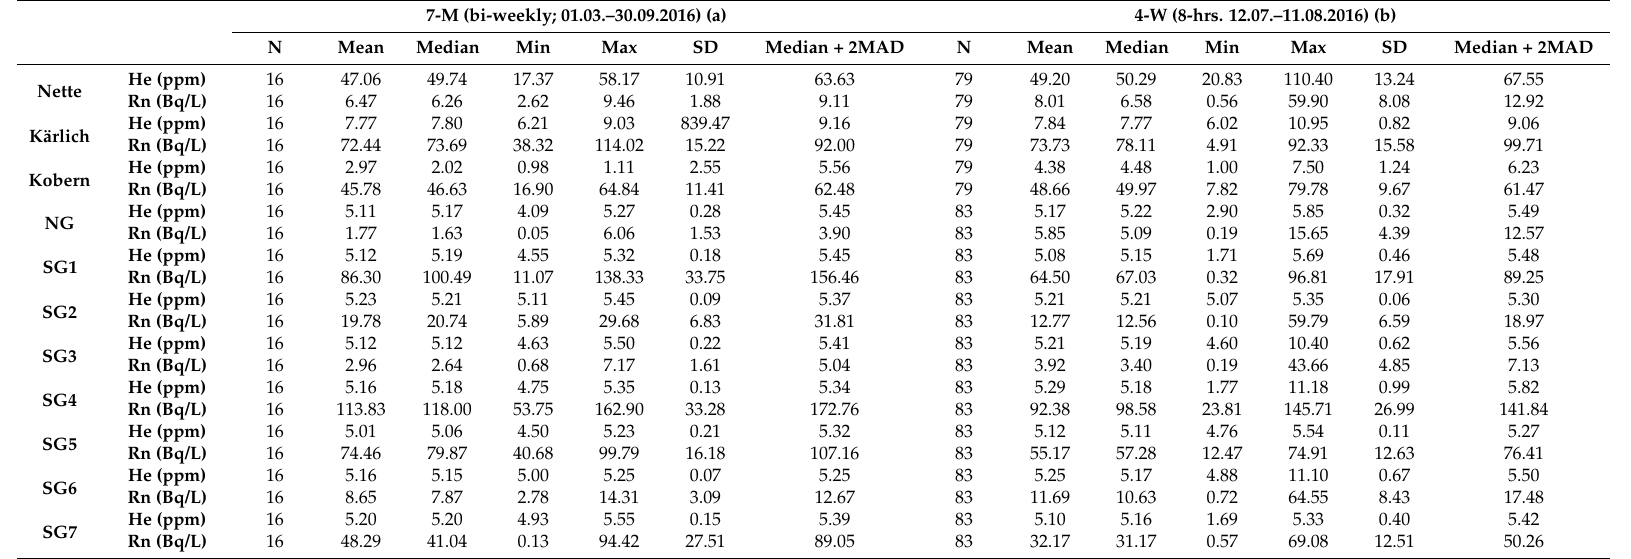
Table A4. Comparison of median He and Rn concentrations in NG, SG, and mineral springs for (a) the 7-M and (b) 4-W samples. Data for mineral springs are extracted from Berberich et al. (2017 [35]). Data for NG and SG from this